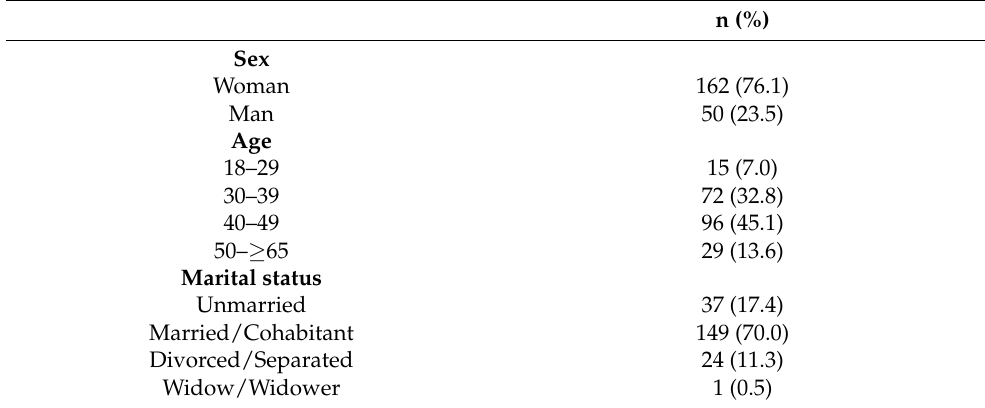
Table 1. Socio-demographic characteristics of caregivers (N =